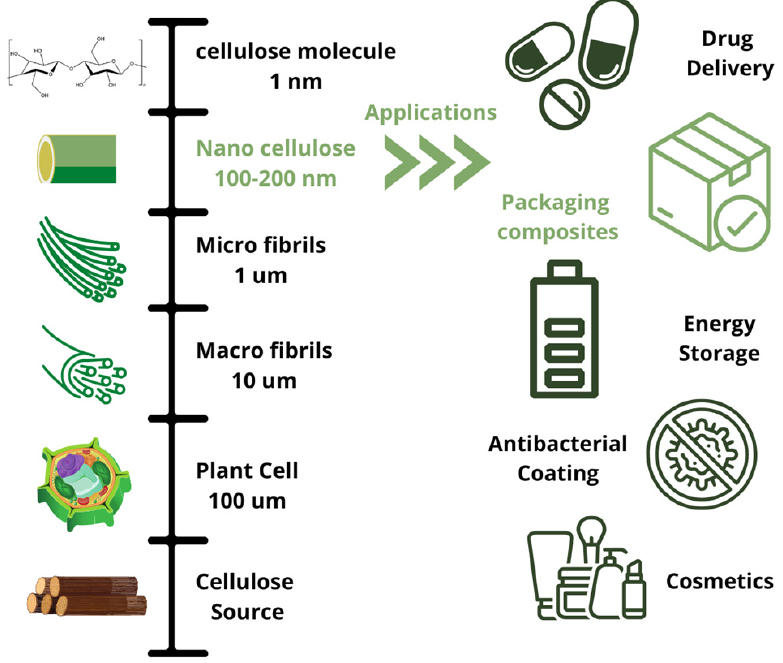
Figure 1. Nanocellulose and its applications in di ff erent